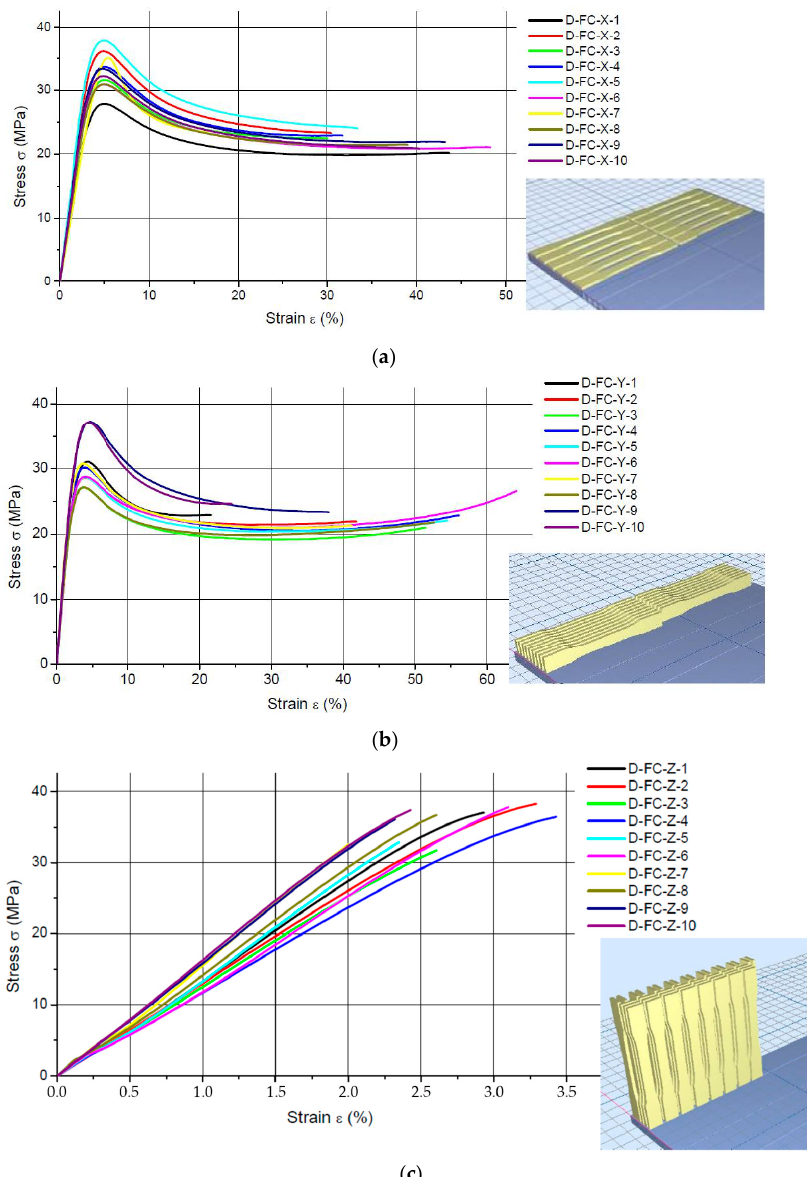
Figure 2. Tensile test data for naturally aged specimens printed using FullCure 720 photocurable resin in: ( a ) the X direction, ( b ) the Y direction; ( c ) the Z direction.